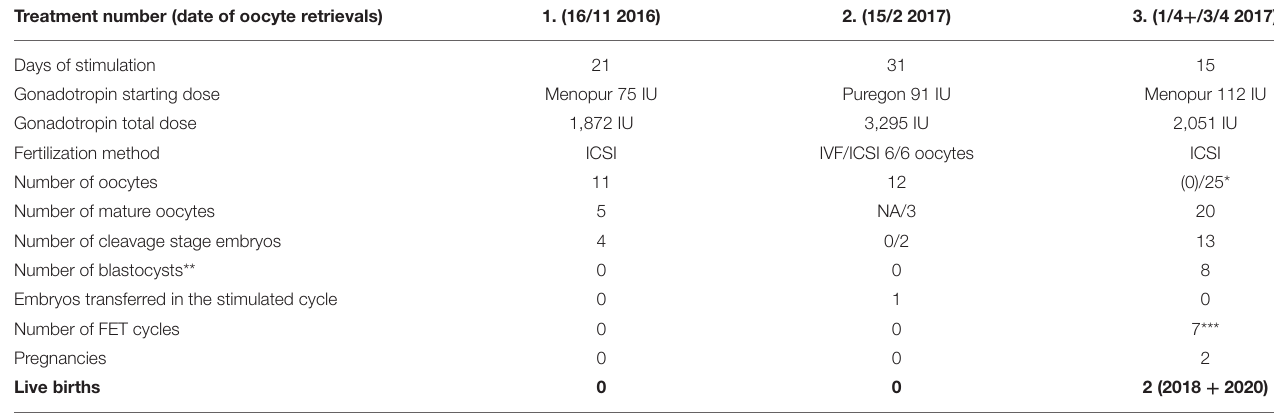
TABLE 1 | Overview of the three controlled ovarian stimulation cycles and associated outcome. Treatment number (date of oocyte